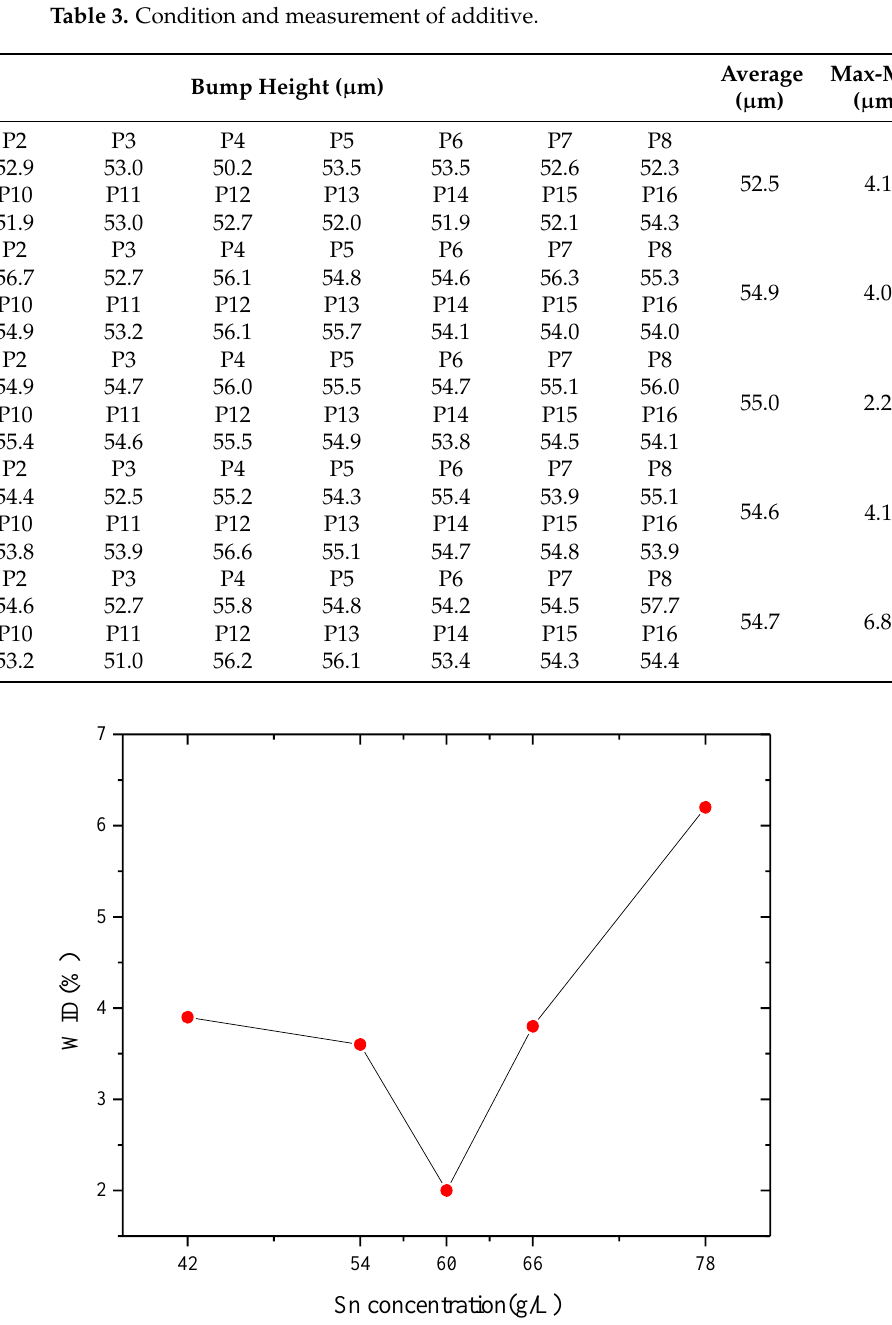
Table 3. Condition and measurement of additive.